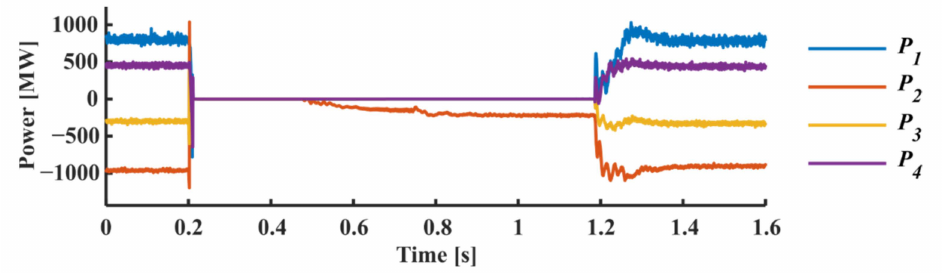
Figure 18. Net injected power P i into the MMC terminals with DC fault at location F2.